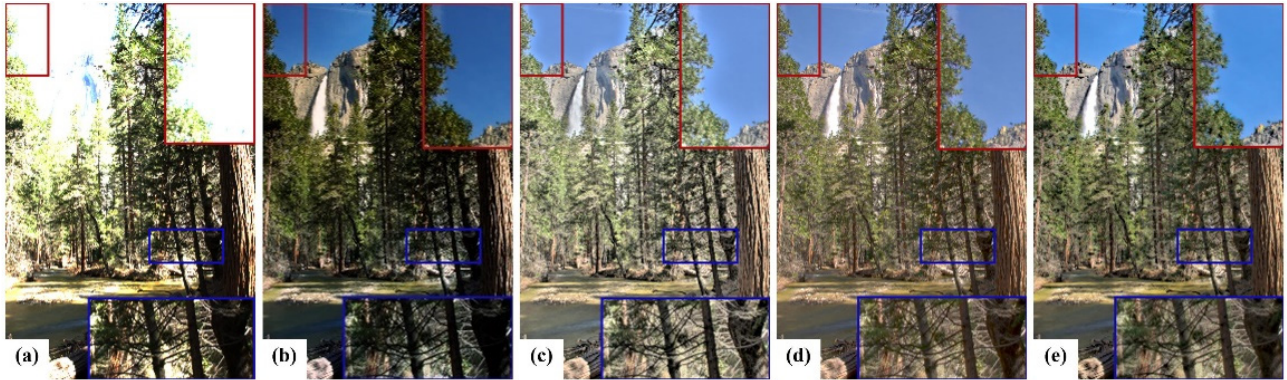
Figure 4. Tone mapped images. ( a ) Image performed by the linear normalization mapping method. ( b ) Image processed by GF. ( c ) Image operated MSD. ( d ) Image processed by iCAM06. ( e ) Images operated by iCAM06-m. The red enlarged area can check artifacts, and the blue enlarged area can check details.